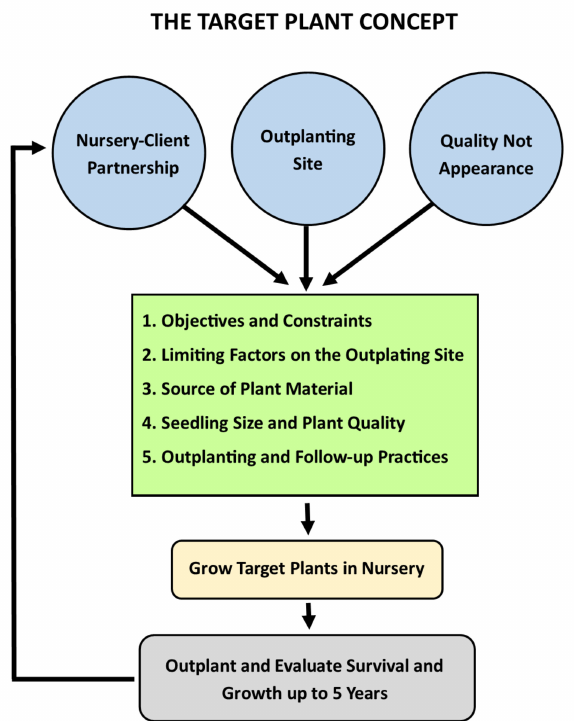
Figure 1. The Target Plant Concept starts with three key elements that guide a cyclic improvement process: nurseries must work together with clients, target plants are defined at the outplanting site, and quality, not appearance, dictates success. Five core components then provide a framework for creating the target plant. The plants are grown, outplanted, and evaluated before starting and improving the cycle again (adapted from Landis